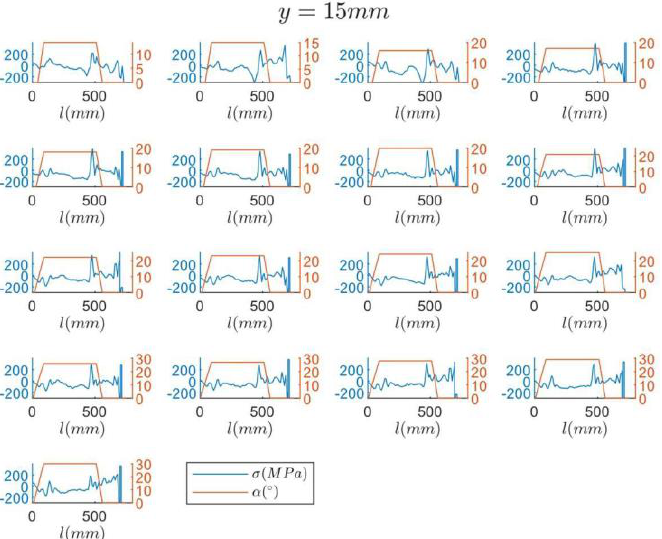
Figure 5. Resulting residual stresses 𝜎 out of the combinations depicted in the last row of Table 1.